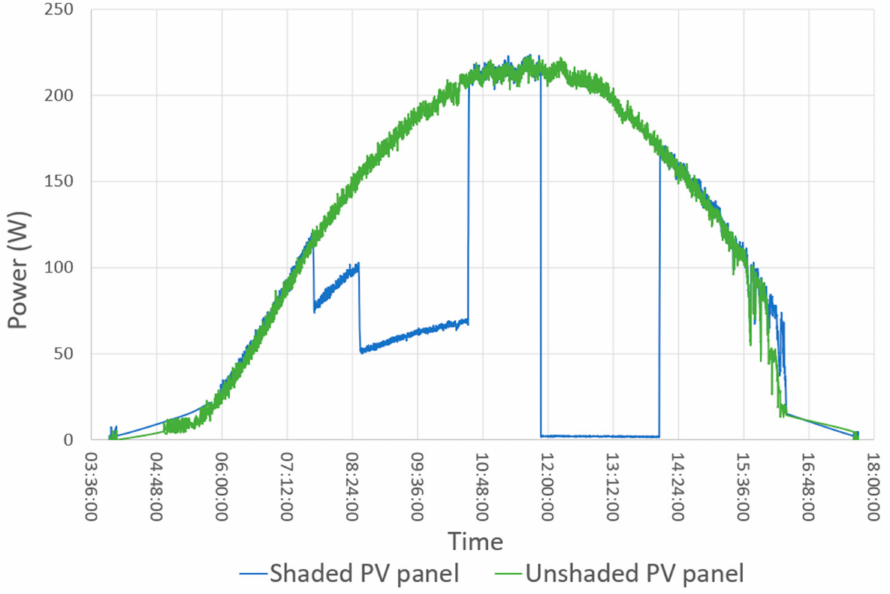
Figure 11. Graph of power generated by two neighbouring PV panels. Panel shading started at approximately 7:30 a.m. The 33% decrease in efficiency recorded (blue colour) was caused by covering one row of PV cells. Another drop in the photovoltaic panel efficiency (by 66%), which appeared after about half an hour, was caused by the activation of another bypass diode (covering another row of cells). The complete uncovering of the panel represents the return to maximum panel efficiency under given weather conditions. Around 12 o’clock, the photovoltaic panel was switched off. This is due to covering only one horizontal row of cells in the vertically aligned PV panel. The tests confirmed the known principle of operation of shunt diodes in PV panels, but their main purpose was to prove that SmartPV devices correctly identify shading, or damage to the panel. For comparison, the power generated by an unshaded photovoltaic panel is marked green in the